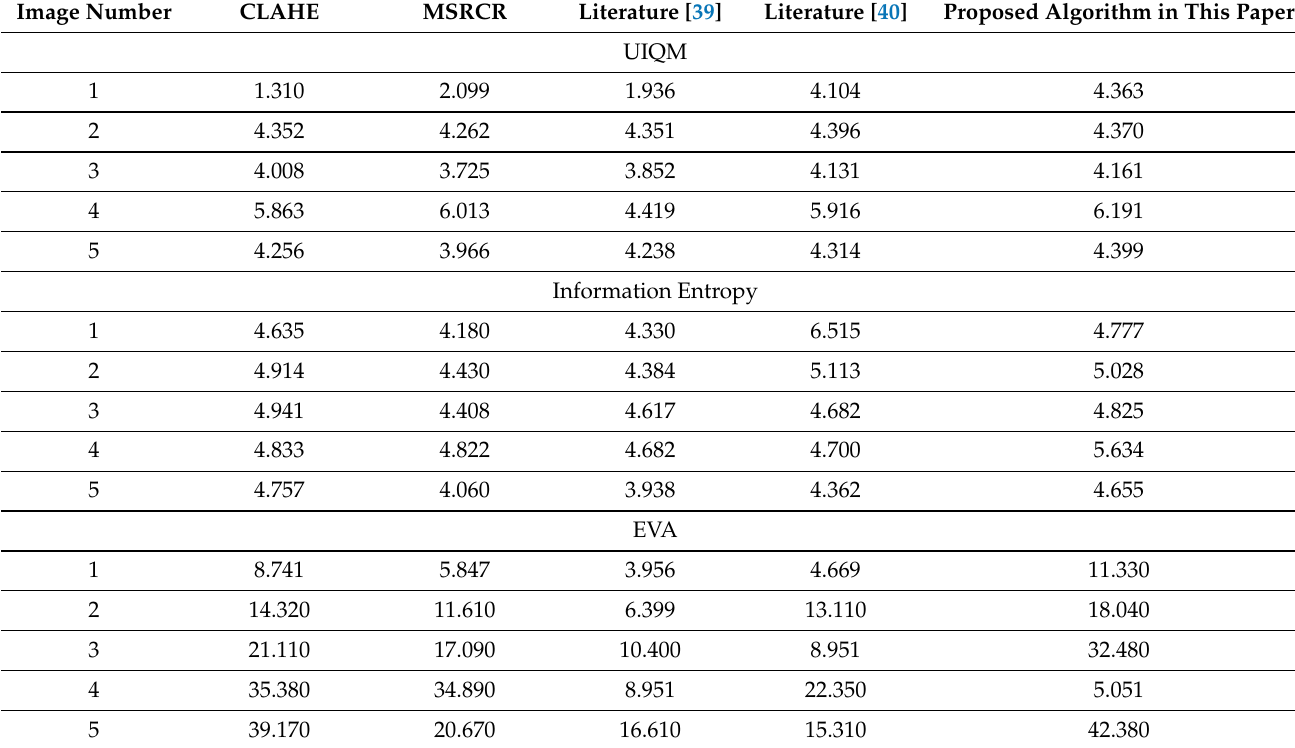
Table 1. Underwater image quality